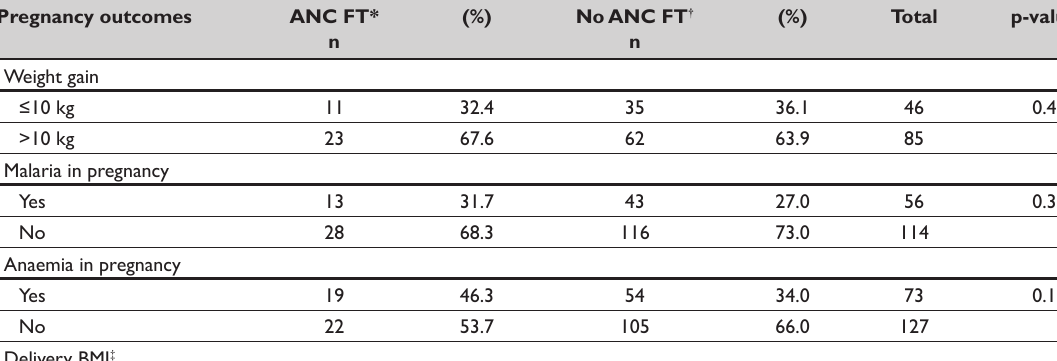
Table 2: Pregnancy outcomes of women who attended antenatal care visits in the first trimester in the Buea Regional Hospital, January – March 2013